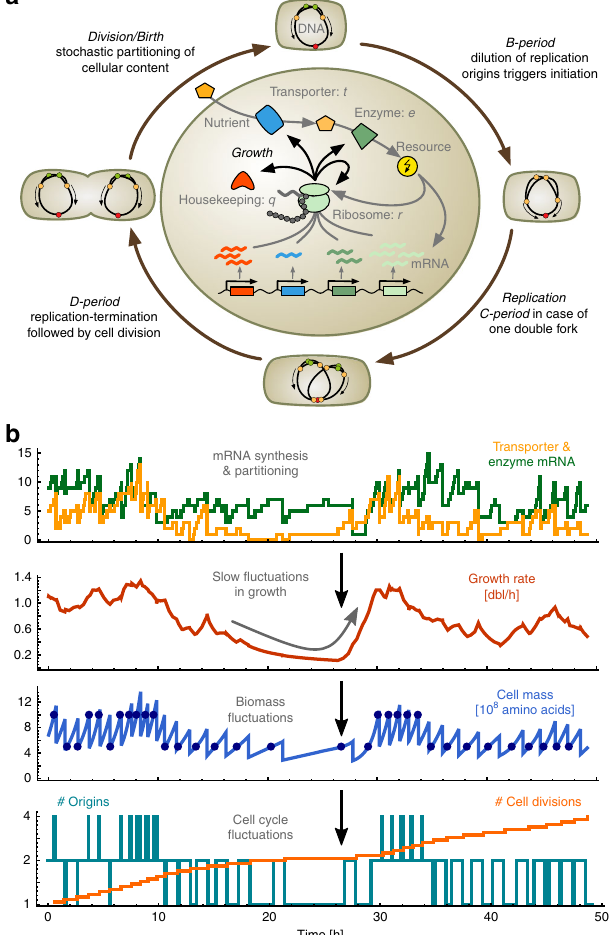
Fig. 1 Stochastic model of single-cell growth. a The outer cycle illustrates the cell cycle model based on the Cooper – Helmstetter model of bacterial replication. We assume initiation of a new round of replication at a fi xed concentration of DNA-origins, analogous to a fi xed initiation mass per DNA- origin 25 , thus growth dynamics schedule the replication events and are determined by the intracellular model (inner circle). The latter describes import and metabolism of resources, and how they fuel gene expression, where the rate of protein-biosynthesis determines growth. Stochasticity of cellular dynamics is a result of the intrinsic stochasticity of the various reactions and the random partitioning of the cellular content at division. b Stochastic simulations illustrate the propagation of intrinsic fl uctuations in single cells: mRNAs are synthesised at low numbers per cell (yellow & green lines), which affects protein production and so growth rate (red line). Fluctuations in growth lead to temporal variations in cell mass that can span several cell cycles (blue line), causing fl uctuations in the number of replication origins (teal line), in the mass at initiation ( fi lled circles), and consequently in cell divisions (orange